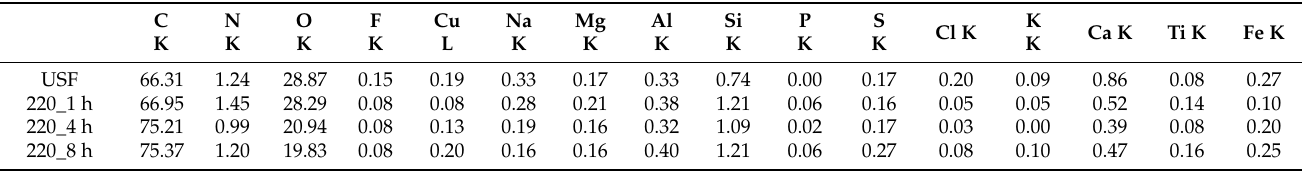
Table 4. Results of EDS analysis (ZAF method),